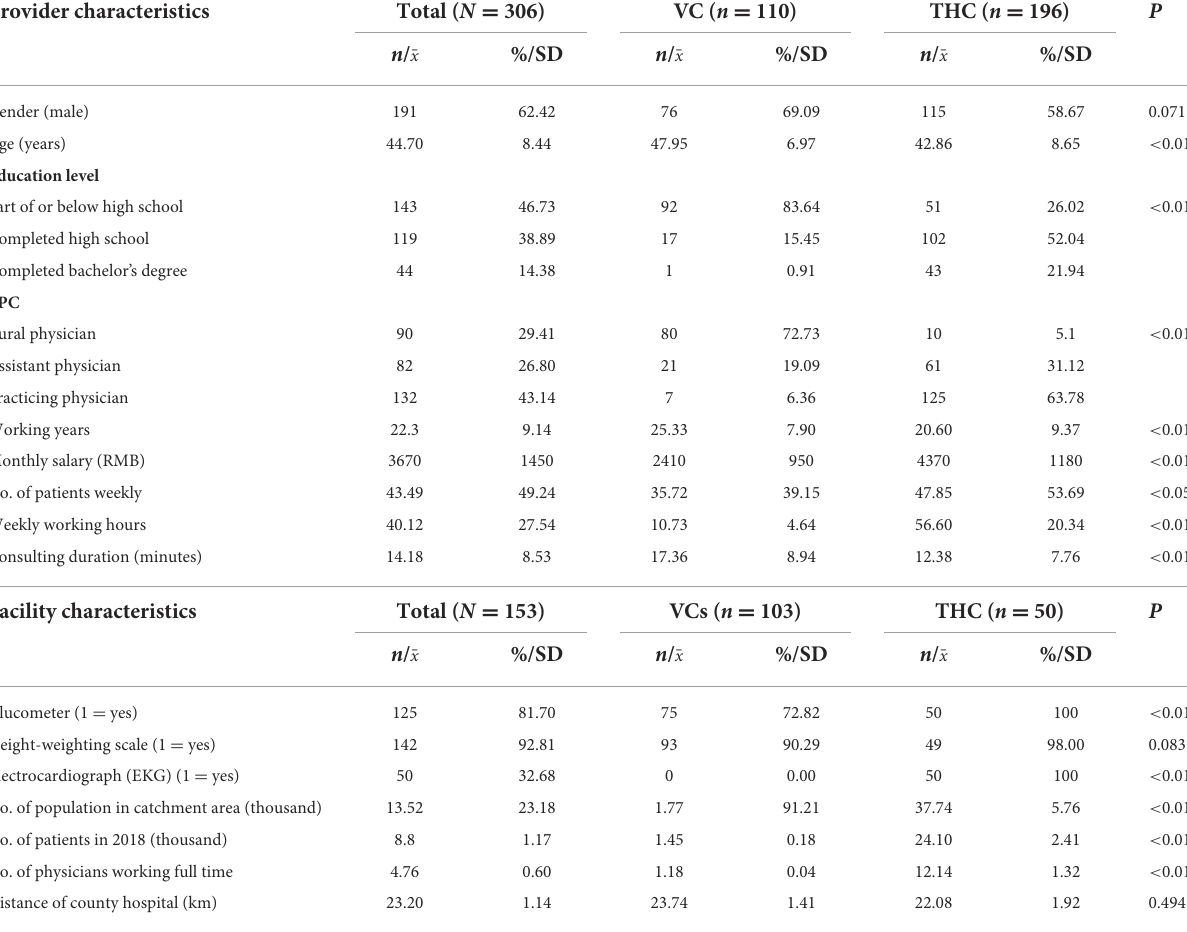
TABLE 1 Medical provider and facility